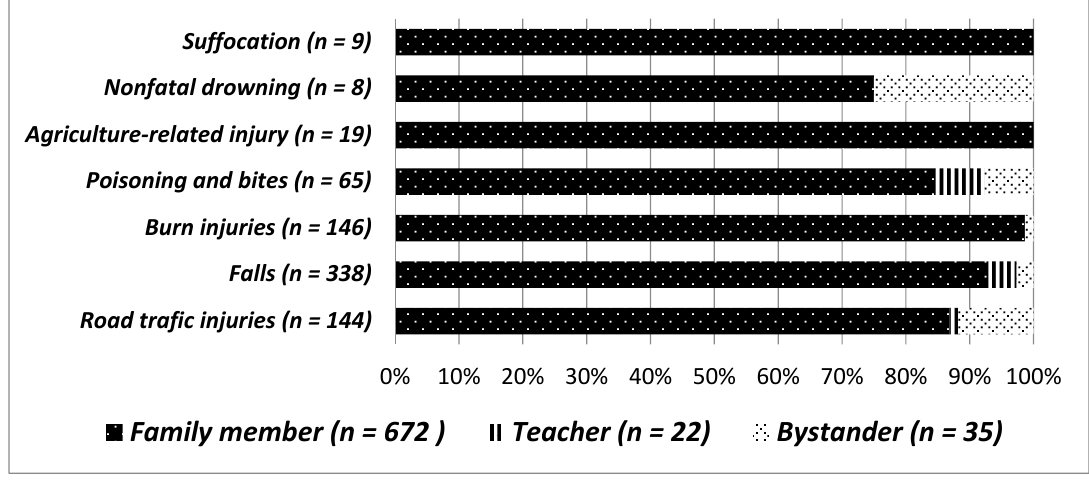
Figure 1. First aid care providers in different injuries.